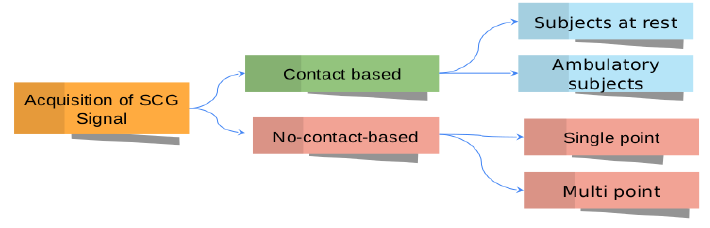
Figure 2. Taxonomy of the SCG acquisition